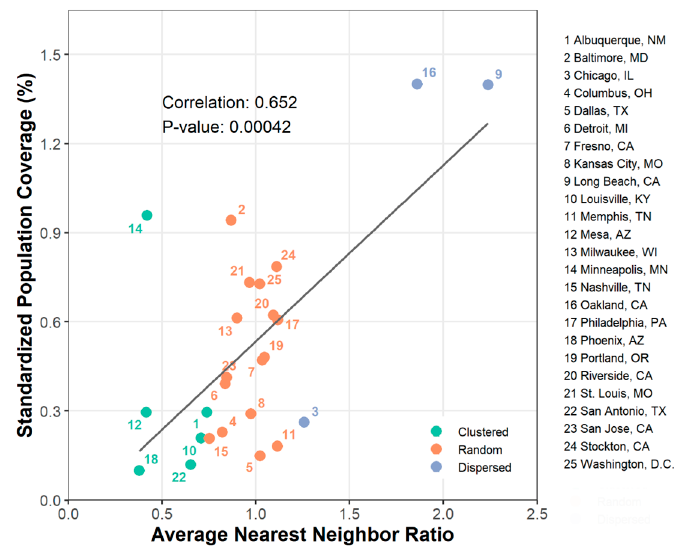
Figure 5. Association between SPC and ANN ratio. Green, orange, and blue indicate the cities where cooling centers were clustered, randomly distributed, and dispersed, respectively.